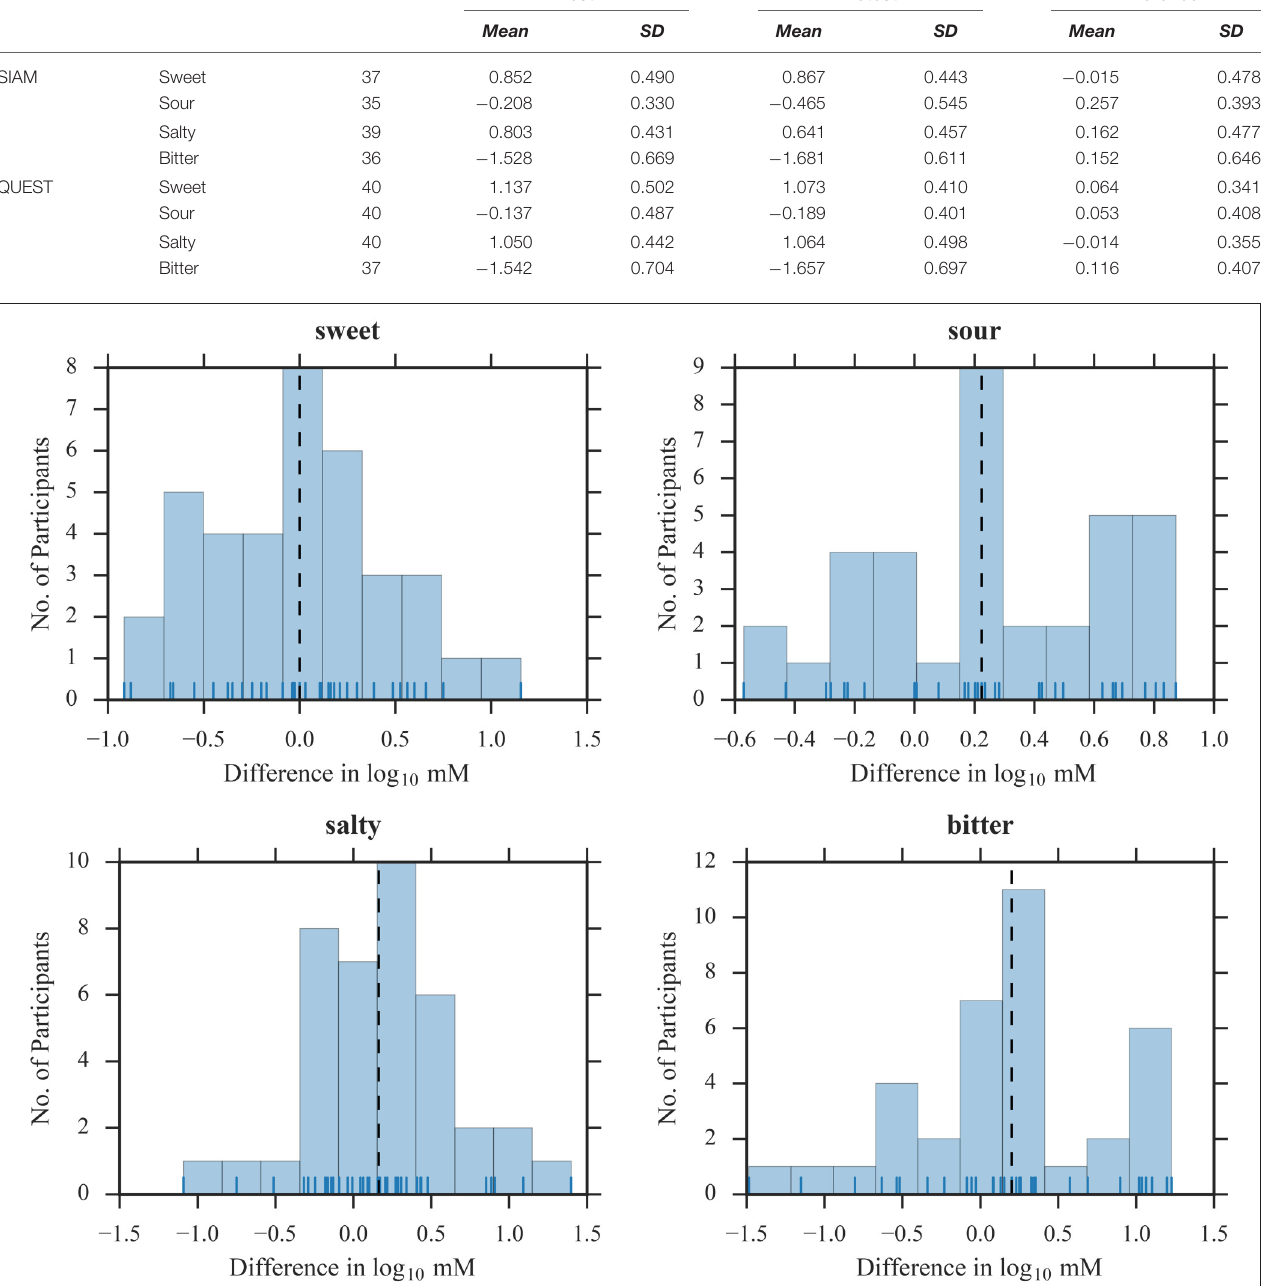
TABLE 3 | Mean threshold estimates and respective standard deviations in test, retest, and the difference between both sessions. Method